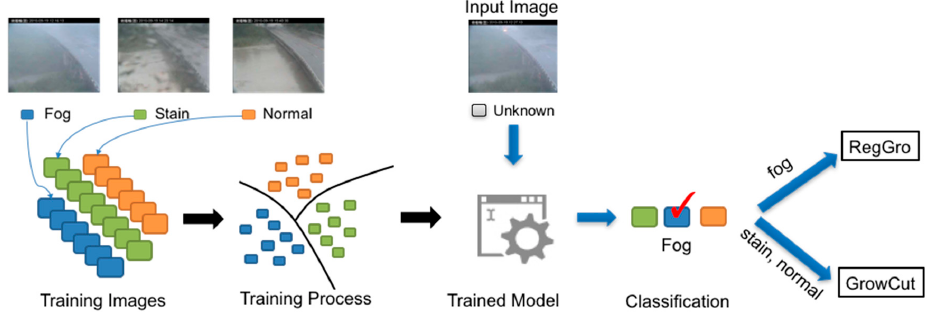
Figure 4. Flowchart of the training model and classification input images. During the training process, the training images are labeled as fog, stained, or normal. The hybrid RgGc method classifies input images and then pipes to different growing methods. (Note: The Traditional Chinese in header of all images is represented the location in the Changed Bridge except).